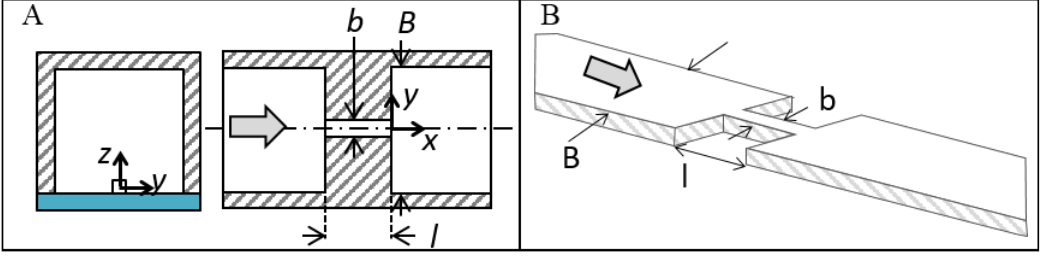
( B ) a schematic figure of the used micro channel adapted from [34].